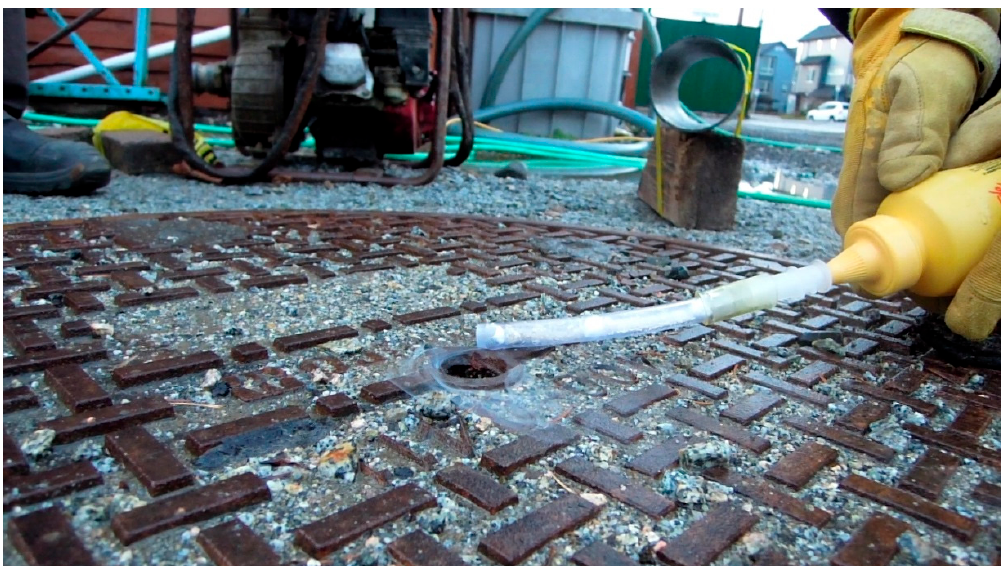
Figure 4. Deflection of ‘smoke’ around opening in the manhole cover.